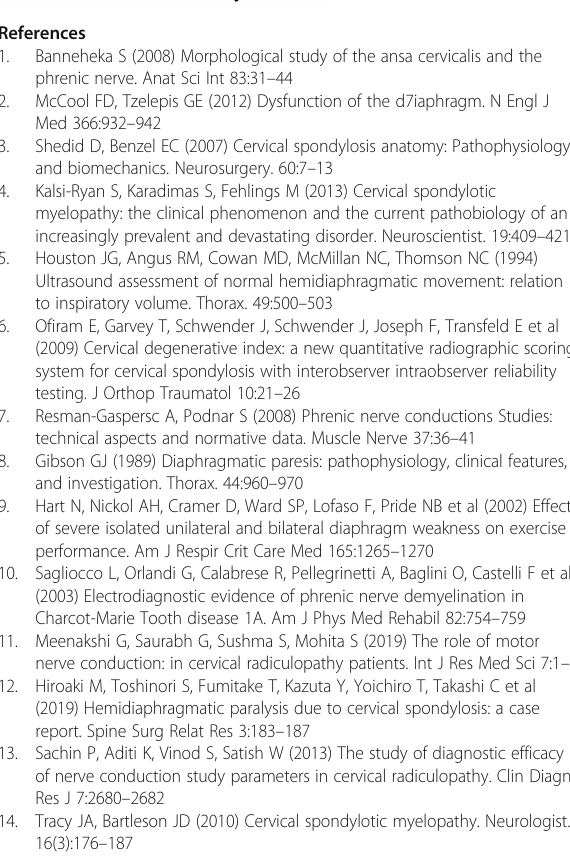
r Spearman coefficient, Rt right, Lt left, DML distal motor latency *** Statistical very high significance at P ≤